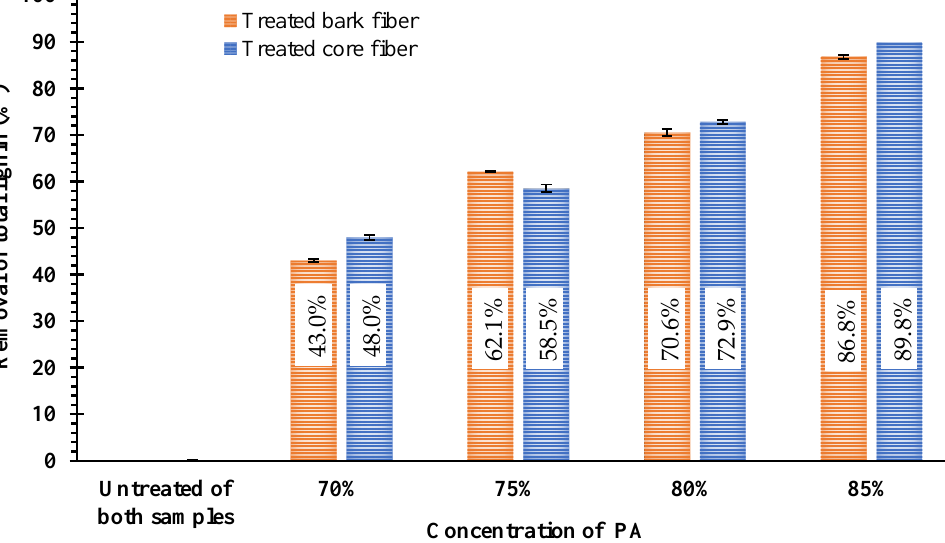
Figure 1. Lignin removal of both treated bark and core fibers.